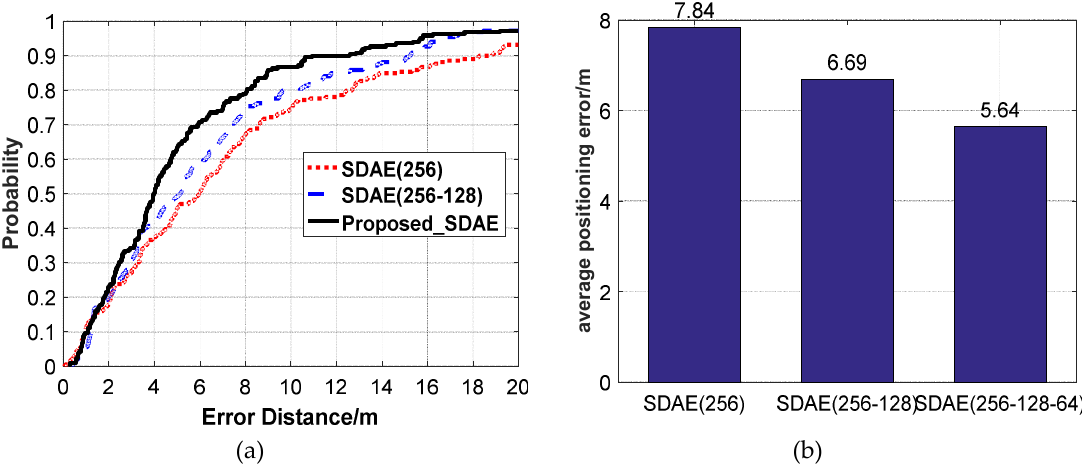
Figure 13. The positioning accuracy using different SDAE network structures. ( a ) CDF positioning errors. ( b ) Average positioning errors.